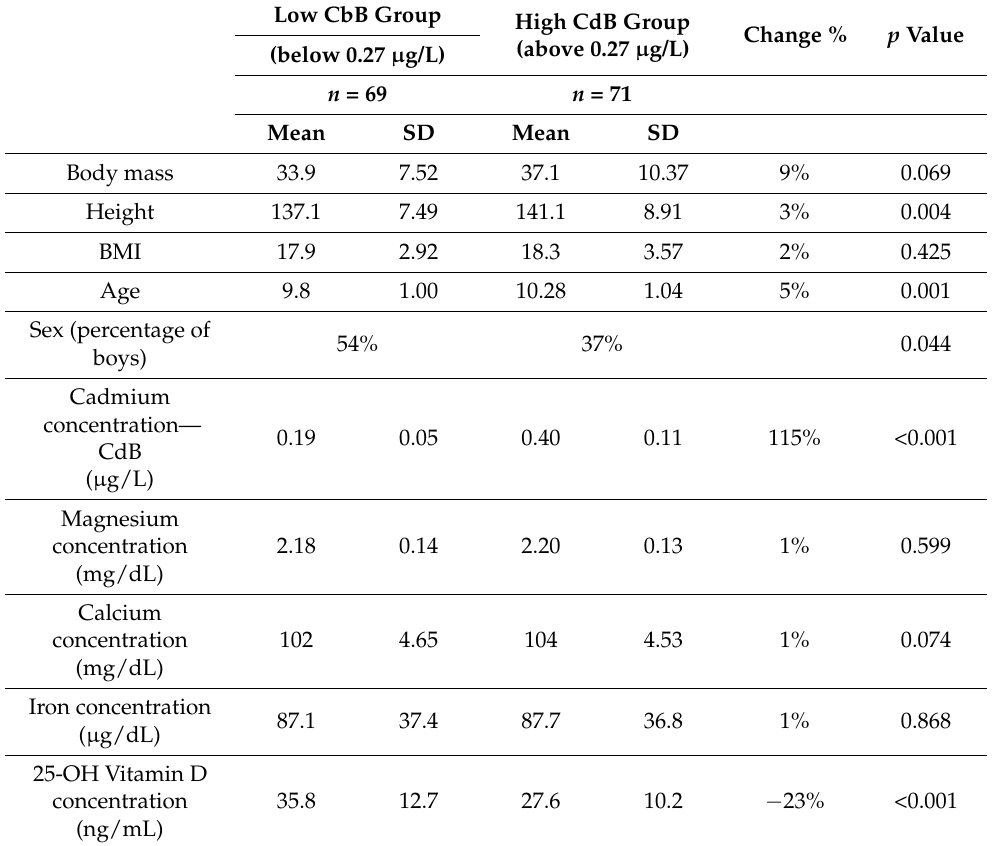
Table 1. Characteristics of the studied population, concentrations of the analyzed metals and vitamin D 3 divided into groups depending on the blood cadmium levels. Low CdB (CdB level below median) and High CdB (CdB value above median). Statistically significant values are marked in bold type. BMI—Body Mass Index. Low CbB